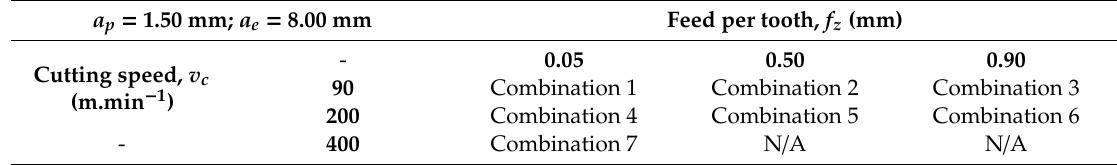
Table 3. Combinations of cutting parameters of high feed face